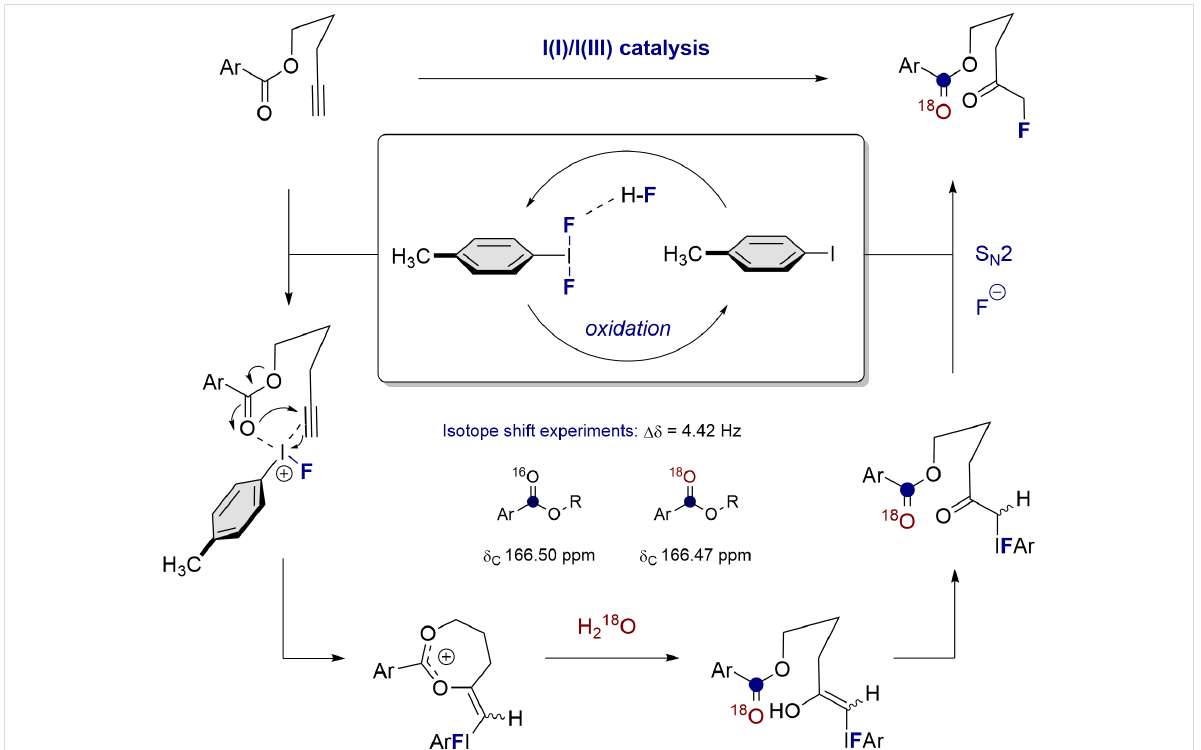
Figure 5: An overview of the I(I)/I(III)-catalysed fluorohydration of